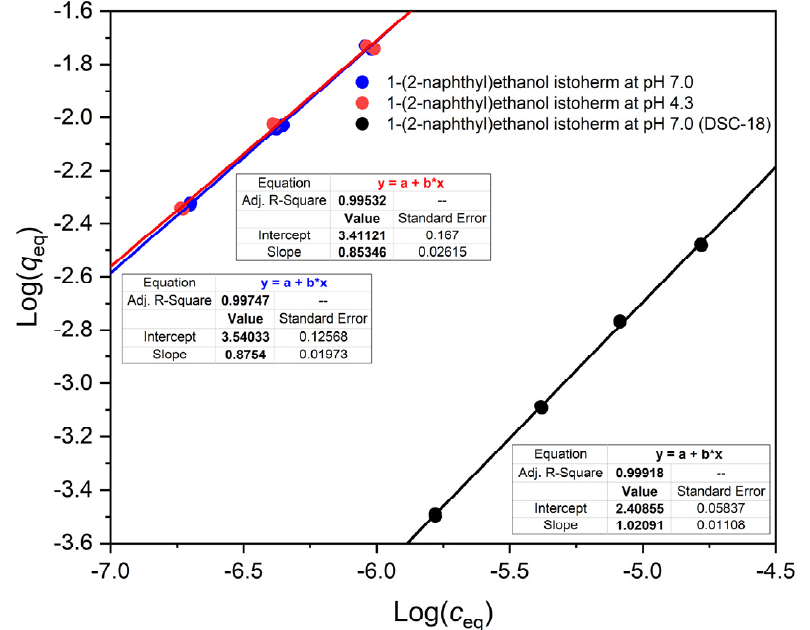
Figure 4. Comparison of 1-(2-naphthyl)ethanol isotherms under different adsorption conditions. All isotherms were measured in 20% methanolic buffers. Isotherms were measured on OASIS ® HLB at pH 7.0 (blue) and at pH 4.3 (red), respectively. The isotherm on DSC-18 (a conventional C18 sorbent) was measured at pH 7.0 ( black ). Linear equations are shown in the figure with the corresponding colors.